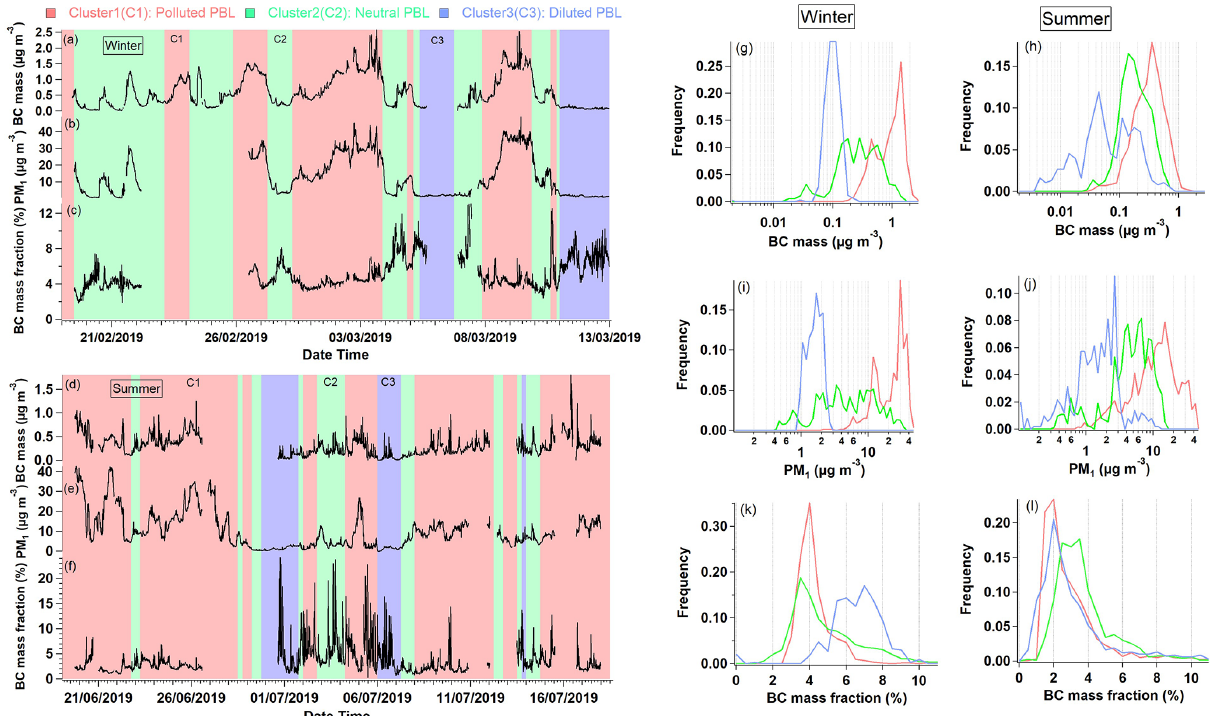
Figure 3. Time series of BC mass (a, d) , PM 1 derived from the SMPS size distribution (b, e) , and BC mass fraction (c, f) at both seasons, shaded by the periods in the identified three clusters, by red, green and blue corresponding to cluster 1 (C1), cluster 2 (C2), and cluster 3 (C3), respectively. Frequency histograms of BC mass (g, h) , PM 1 (i, j) , and BC mass fraction (k, l) for each cluster in both